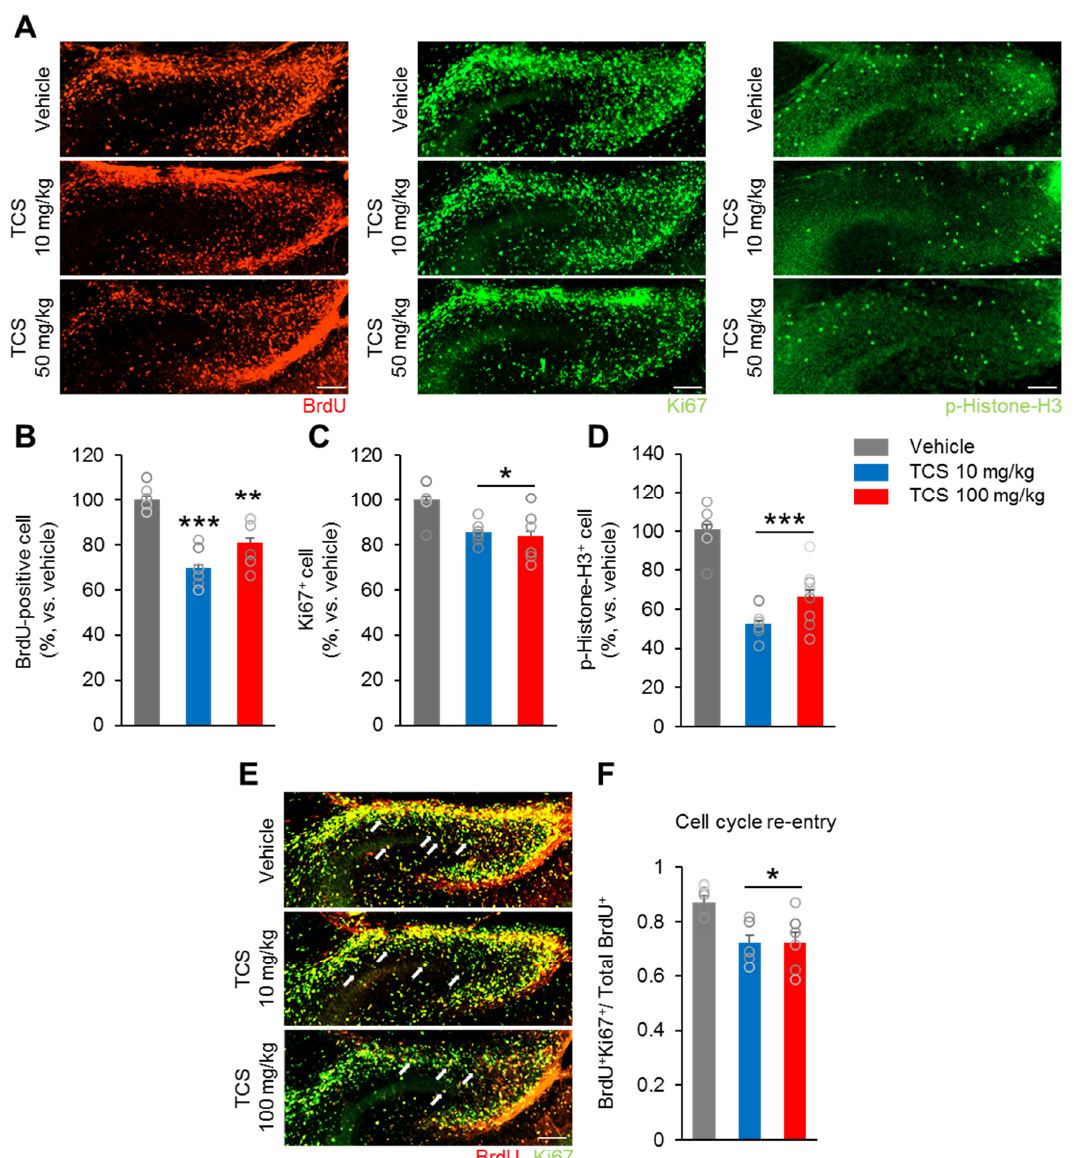
Figure 2. TCS-exposure alter neurogenesis in in vivo. ( A ) Cortical sections from from vehicle and TCS-treated groups at E18.5 were immunostained using BrdU antibody (red), Ki67 (green) and phospho-histone H3 antibody (green). ( B – D ) Quantification analysis of A . The number of BrdU + , Ki67 + and p-Histone-H3 + cells were decreased in the TCS-treated groups compared to vehicle group. However, there was no difference in the number of BrdU + , Ki67 + and p-Histone-H3 + cells between TCS 10 mg/kg and 100 mg/kg groups ( n = 5 per group). ( E ) The cell cycle re-entering was calculated by dividing the number of BrdU-positive/Ki67-positive cells by the total number of BrdU-positive cells. Arrows indicate re-entry cell cycle cells (BrdU-positive/Ki67-positive). ( F ) TCS-treated groups exhibited lower number of cells re-entering the cell cycle compared to the vehicle group. Data represent mean ± SEM. Statistical significance was determined by one-way ANOVA with Bonferroni correction. * p < 0.05 vehicle vs. TCS, ** p < 0.01 vehicle vs. TCS, *** p < 0.001 vehicle vs. TCS. Treatments: vehicle; 0.1% DMSO, TCS; 10 −6 mol/L or 10 −8 mol/L.